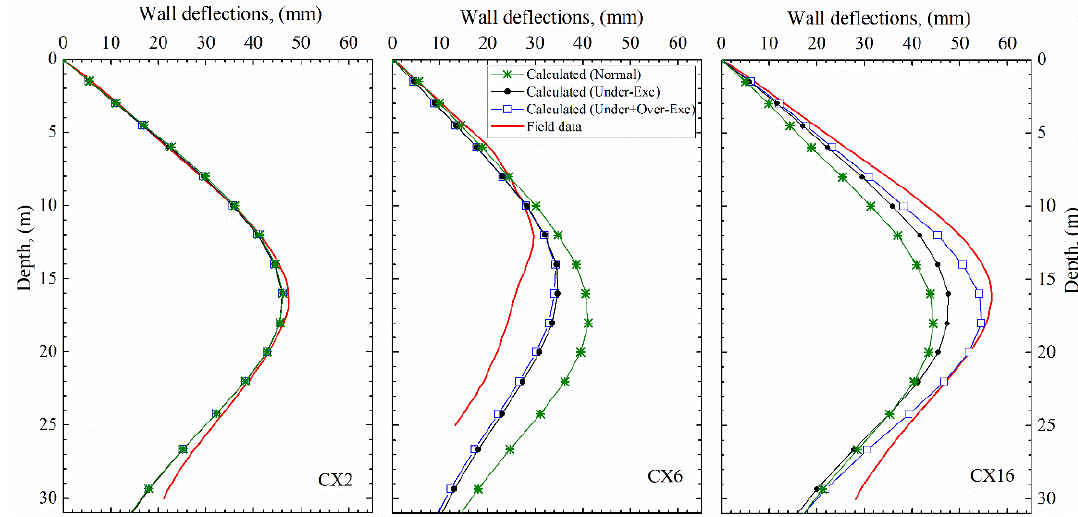
Figure 23. Wall deflection profiles at CX2, CX6, and CX16.